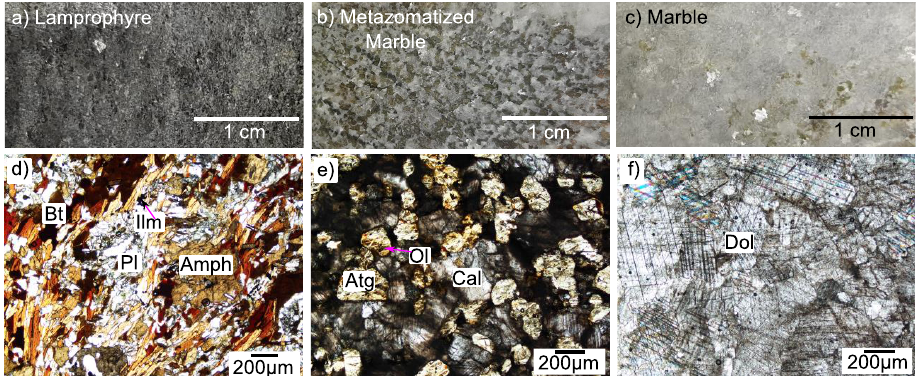
Figure 3. Hand specimens and thin section photographs of the three representative samples collected for this study. ( a ) Dark, medium-grained lamprophyre dyke sample. ( b ) Olivine-bearing sample from the partially serpentinized area. ( c ) Marble sample collected away from the metasomatized area. Scale given for panel c is same for all panels. ( d – f ) Thin section photographs of lamprophyre dyke, metasomatized marble, and dolomitic marble, respectively. Bt—Biotite; Ilm—Ilmenite;